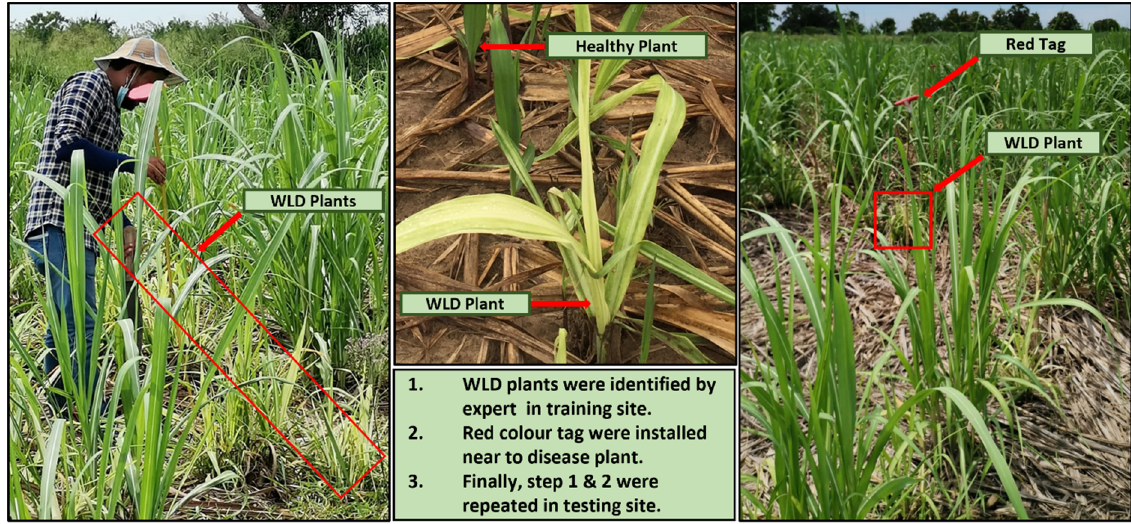
Figure 3. Ground truth procedure in the studied sugarcane field.